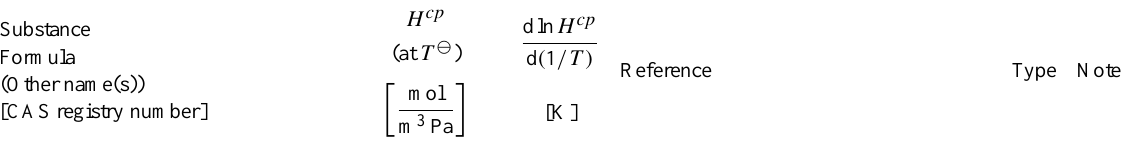
Table 6: Henry’s law constants for water as solvent